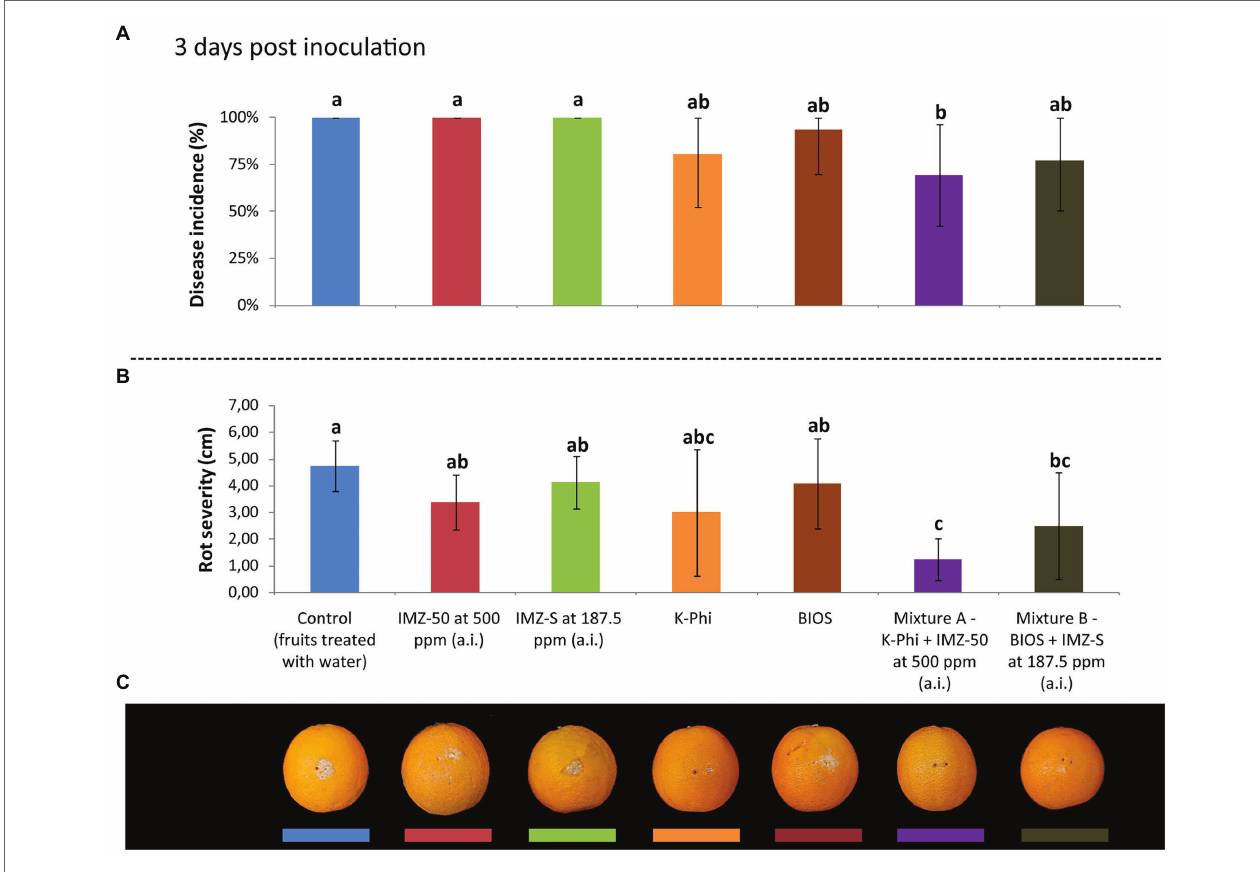
FIGURE 3 | Evaluation of the induced resistance as (A) disease incidence (%) and (B) rot severity (cm), as well as observed symptoms of decay in fruits (C) , caused by Penicillium digitatum strain, P_digit_G.B.A., in Citrus sinensis cv. Moro nucellare orange fruits treated with water (control) or Imazalil [emulsifiable concentrate formula at 50% w/v of active ingredient (a.i.)] (IMZ-50) at 500 ppm a.i., Imazalil sulfate (formula at 7.5% w/v of a.i.; IMZ-S) at 187.5 ppm a.i., potassium phosphite (K-Phi) formula (57% w/v) at the dosage of 0.25%, natural biostimulant (BIOS) formula at the dosage of 0.15%, Mixture A (K-Phi: 0.25%; IMZ-50: 500 ppm a.i.), and Mixture B (BIOS: 0.15%; IMZ-S: 187.5 ppm a.i.) 3 days postinoculation (d.p.i.). Values sharing the same letters are not statistically different according to the Tukey’s HSD (Honestly Significant Difference) test ( p ≤ 0.05). Bars represent